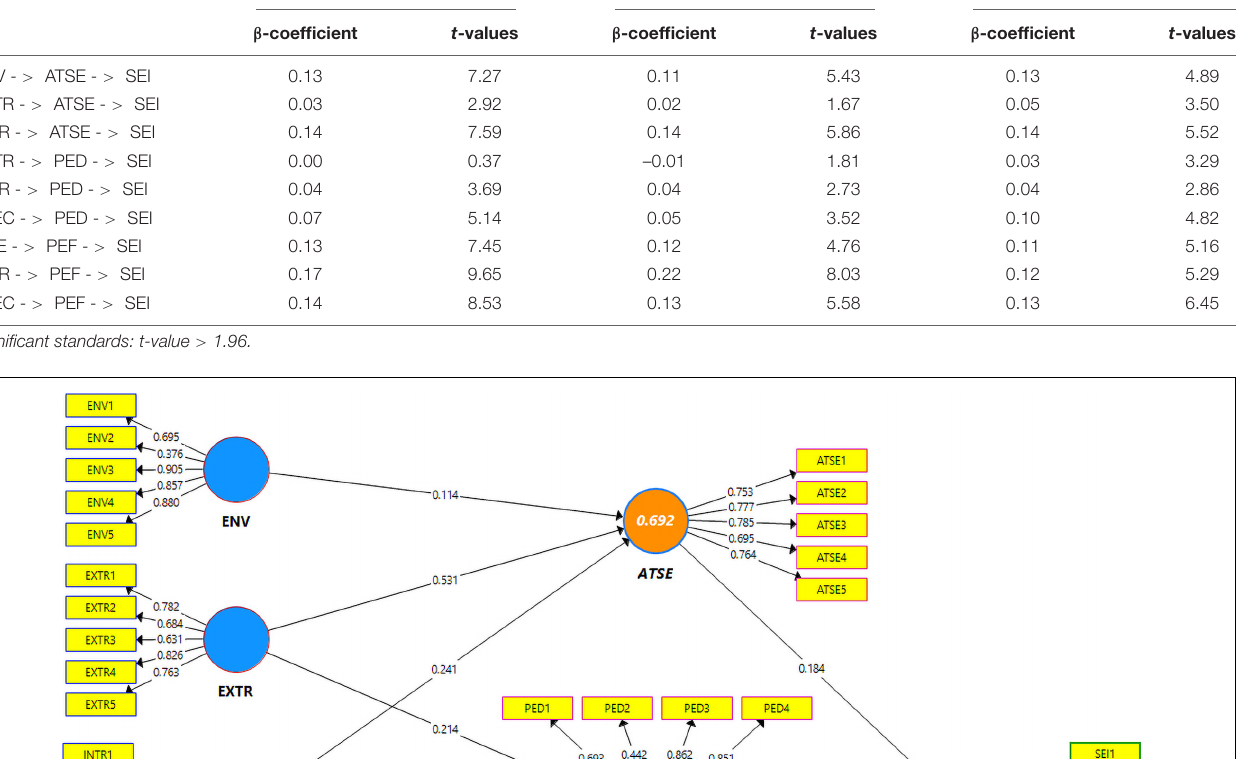
TABLE 8 | Proposed hypotheses mediational effects among constructs of China vs. Pakistan. Paths Total Sample China